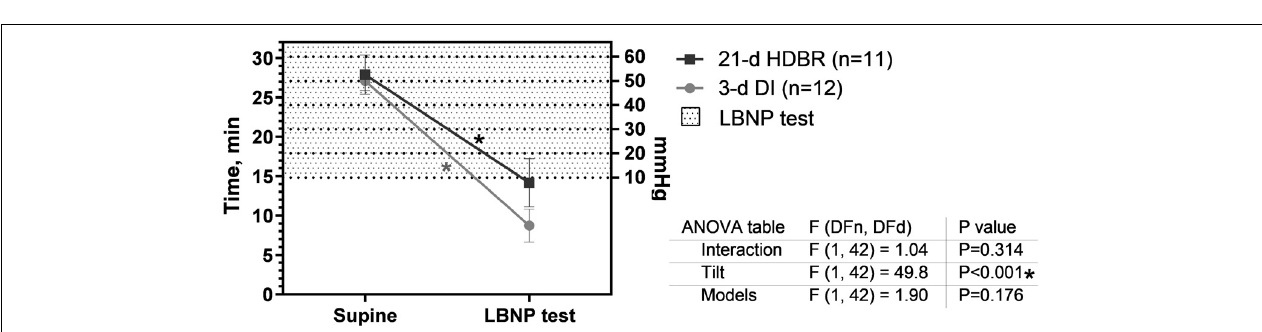
FIGURE 6 | Changes in spontaneous baroreflex (A) and sympathetic index (B) in response to the 80 ◦ tilt test before and after the 21-day head-down bed rest (HDBR) and 3-day dry immersion (DI). Data are the mean ± SEM. # p < 0.05 between groups; * p < 0.05, 80 ◦ vs. the supine position; @ p < 0.05, before vs. after exposure.